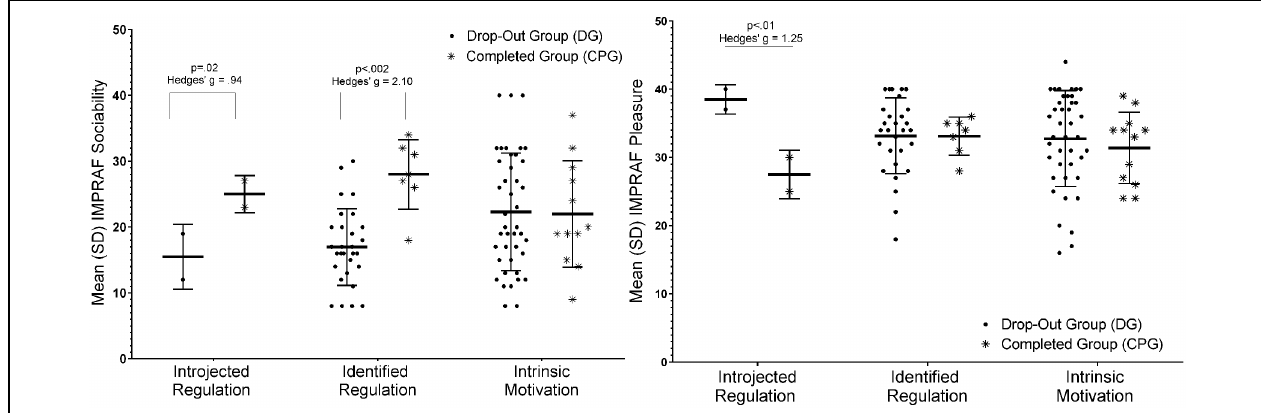
FIGURE 1 | Results of a two-way ANCOVA to evaluate the effect of adherence (CPG, Completed Protocol Group and DG, Drop-out Group). These results were controlled for age and Body Mass Index (BMI) of the participants. ∗ p < 0.05.